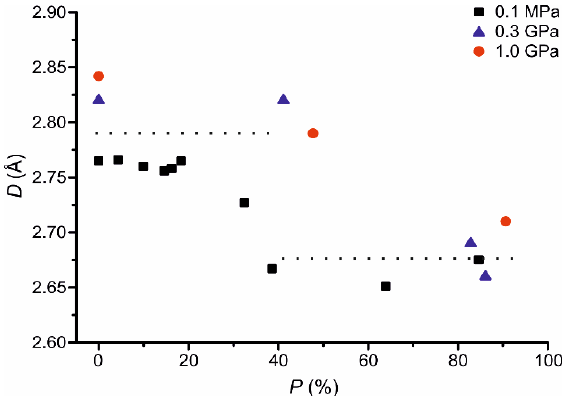
Figure 7. Changes in the D distance between directly reacting carbon atoms along with the reaction progress. The data for 0.1 MPa were taken from [5]. Standard uncertainties are in ranges 0.002–0.03 Å, 0.02–0.05 Å and 0.017–0.05 Å for 0.1 MPa, 0.3 GPa and 1.0 GPa, respectively. For the pure reactant crystals, the di ff erence between D at 0.1 MPa and 1.0 GPa is statistically significant at the 3 σ